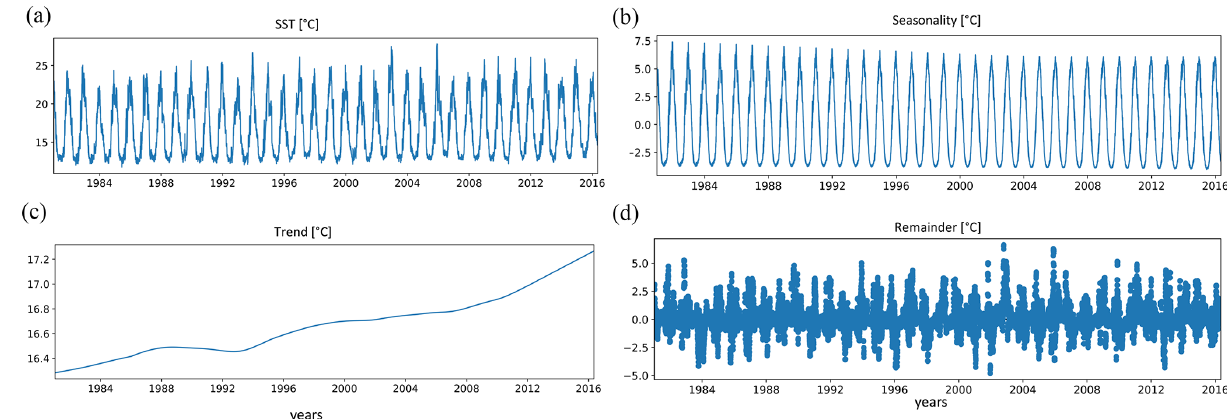
Figure 3. STL decomposition for a SST time series in the western Mediterranean (blue circle in Fig. 1a). (a) SST time series. (b) Time- varying seasonality. (c) Trend. (d)